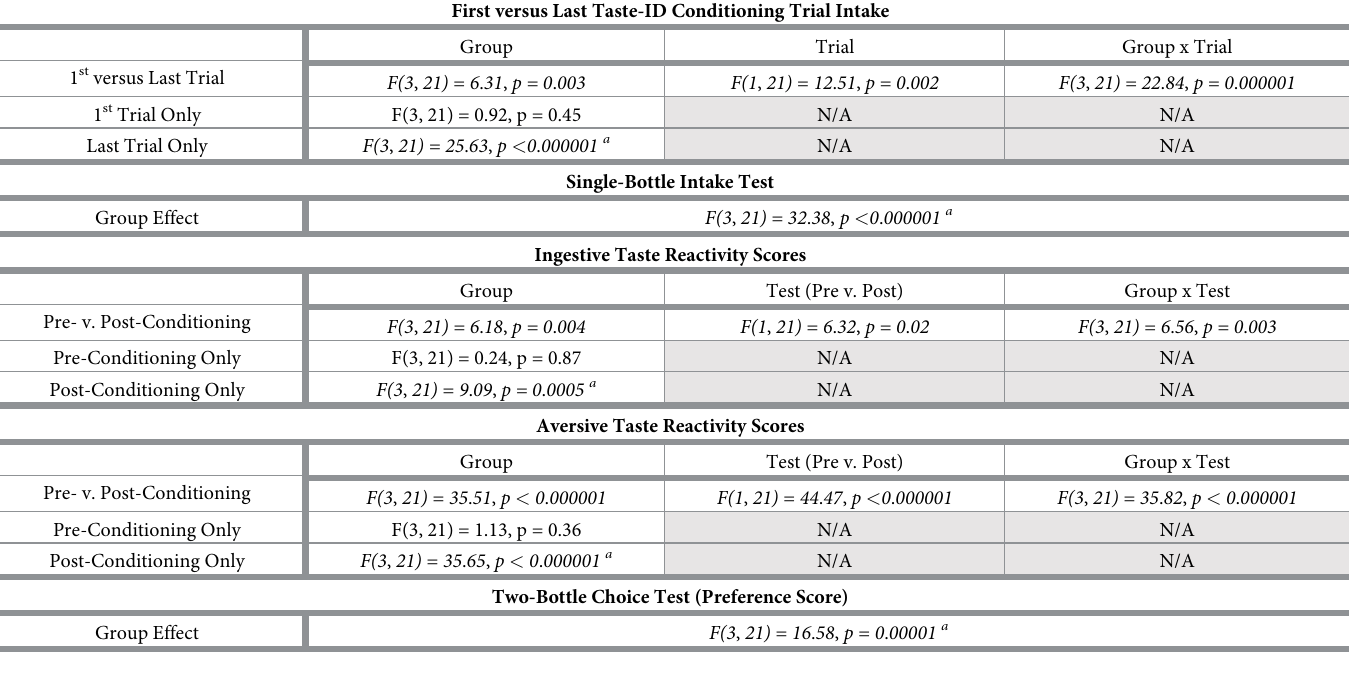
Table 1. Statistical outcomes for Experiment 1.